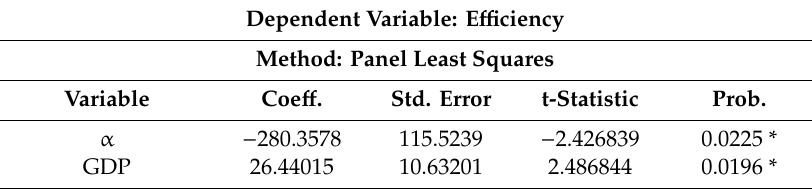
Table 2. Panel data results (Equation